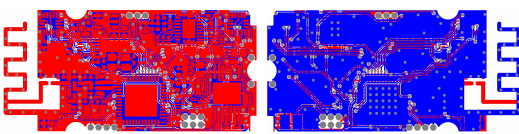
Figure 4. SPW-2: Top view (left) and bottom view (right) of the circuit board.